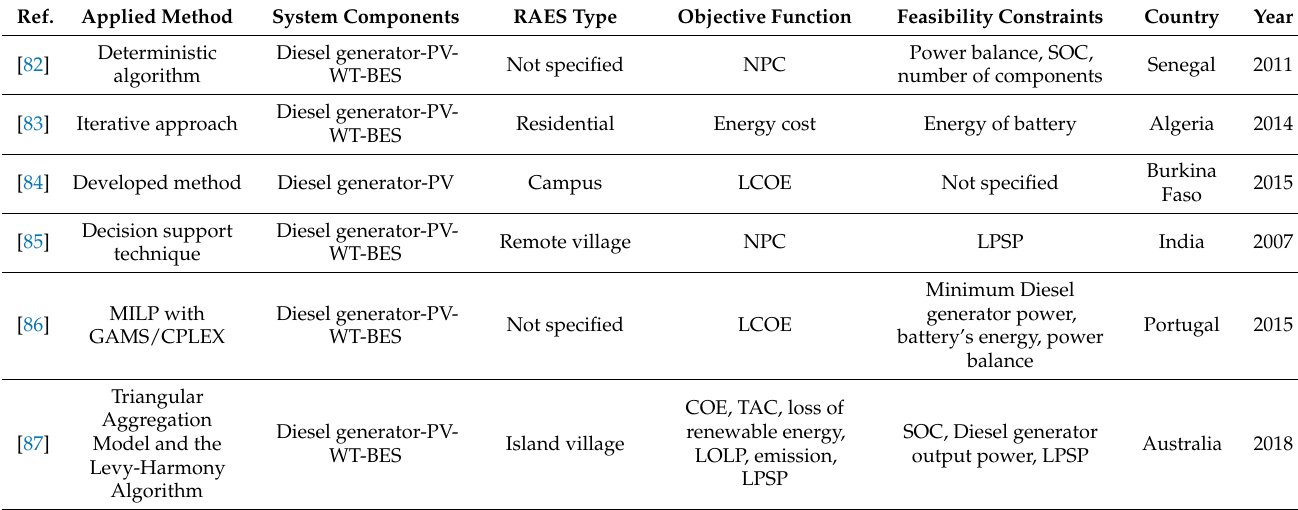
Table 6. Hybrid RAES system optimal planning studies with non-metaheuristic methods.